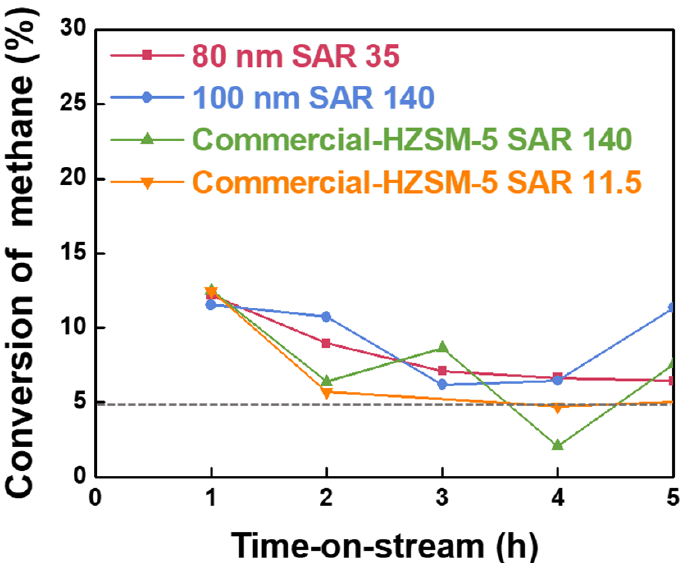
Figure 6. Methane conversion efficiency of seeded grown Al-ZSM-5 as a function of the TOS obtained from obtained from gas chromatograph (GC) analysis. The gray dotted lines indicate the methane conversion line of 5%.